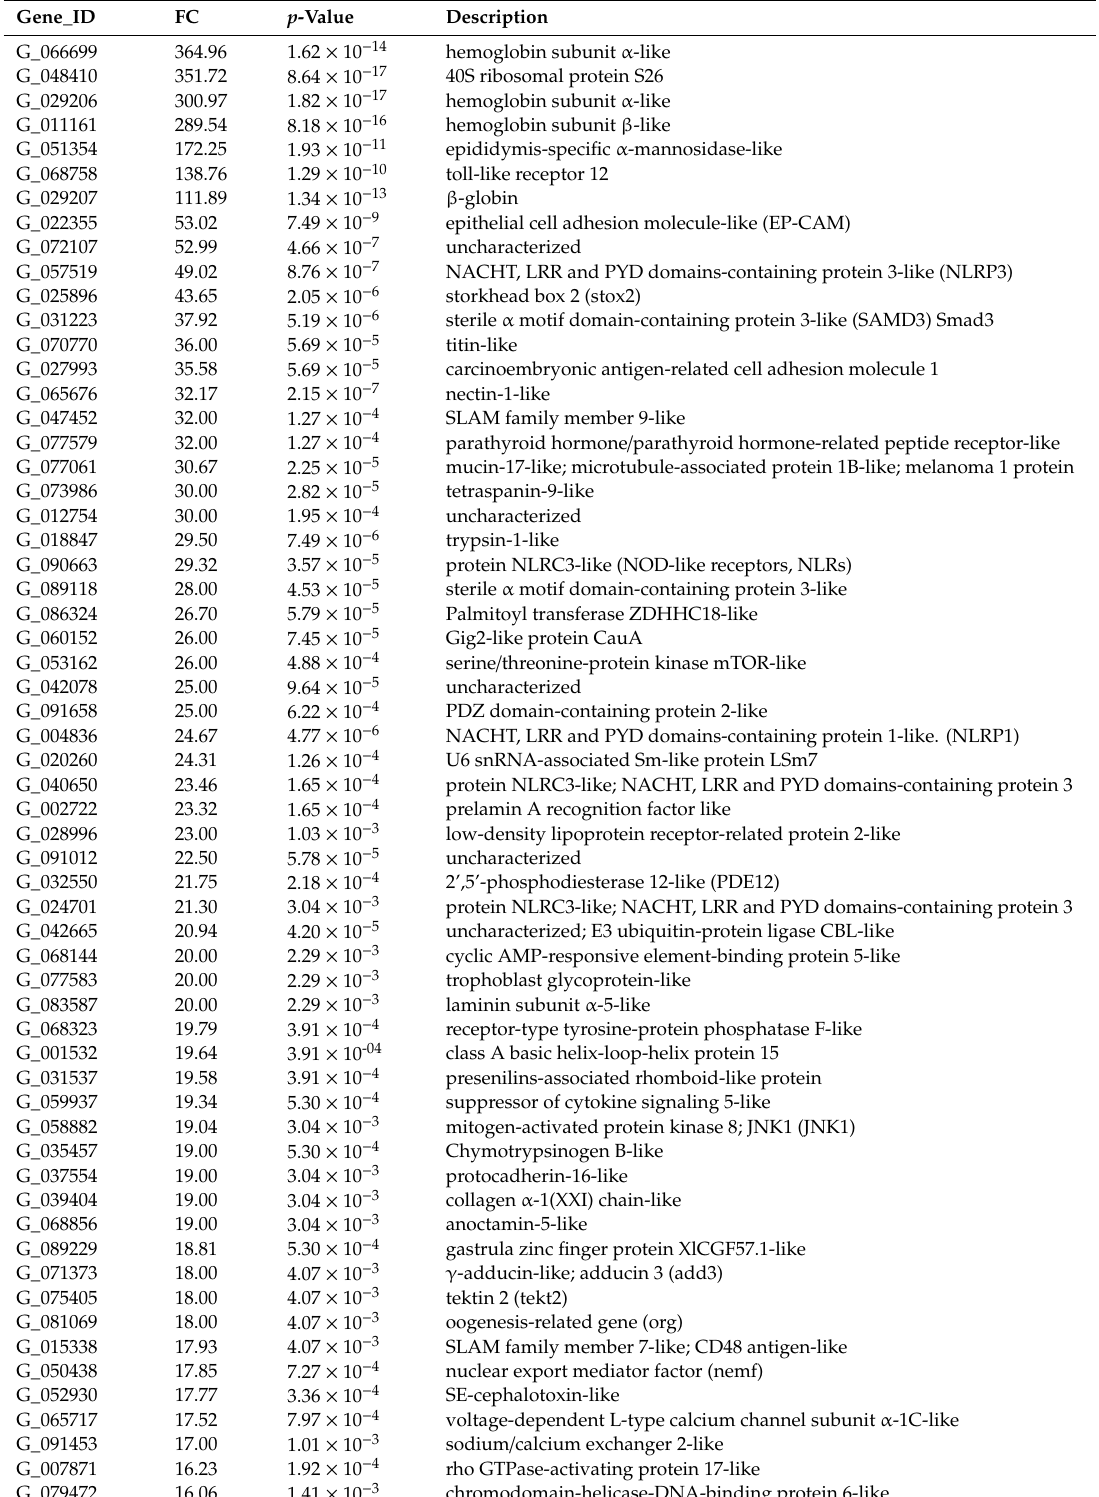
Table 2. Down-regulated DE genes in TM compared to